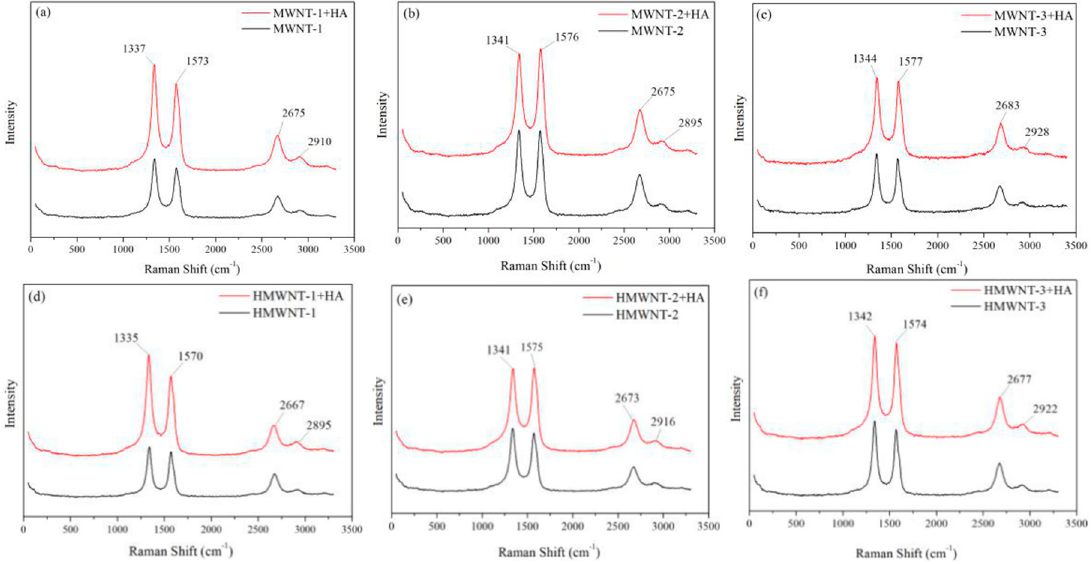
Figure 10. Raman spectra of MWNTs ( a – c ) and HMWNTs ( d – f ) prior to and after HA adsorption.